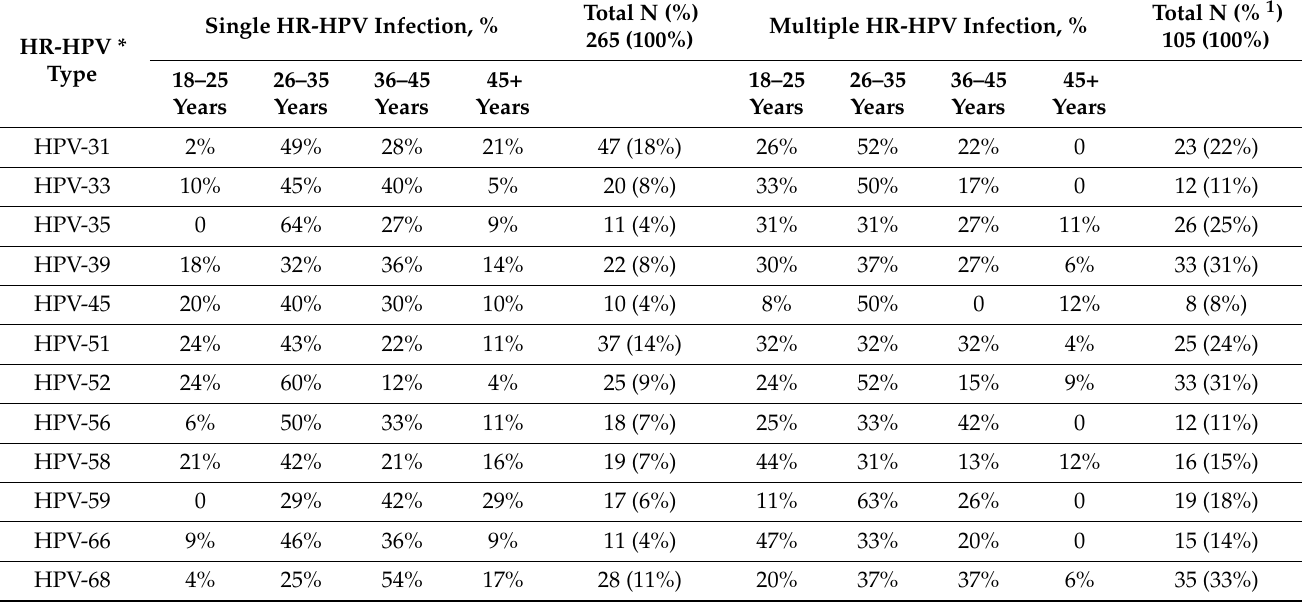
Table 1. High-risk HPV genotypes distribution among single and multiple high-risk HPV infection by age groups ( n =